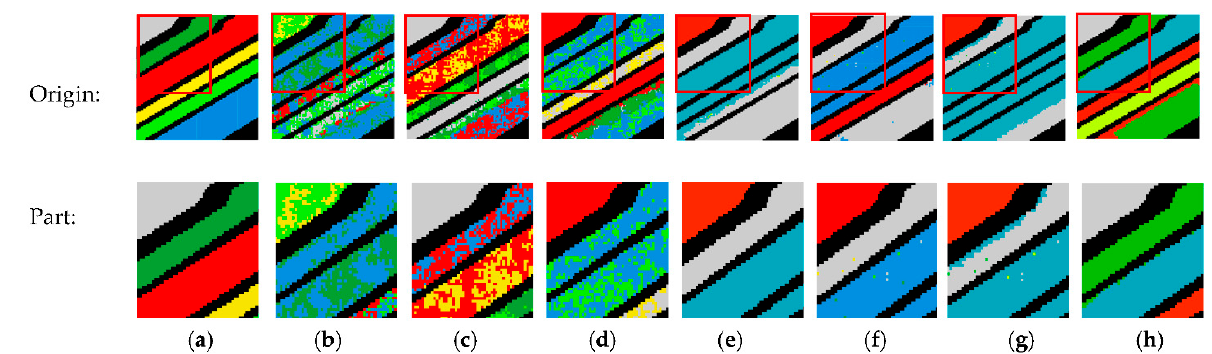
Figure 6. Clustering results obtained using different methods on the SalinasA data set with salt and pepper noise. ( a ) Ground truth. ( b ) LRSC 43.49%. ( c ) SSC 48.60%. ( d ) S4C 51.08%. ( e ) EDSC 61.03%. ( f ) EGCSC 68.03%. ( g ) EKGCSC 45.74%. ( h ) SSAKGCSC